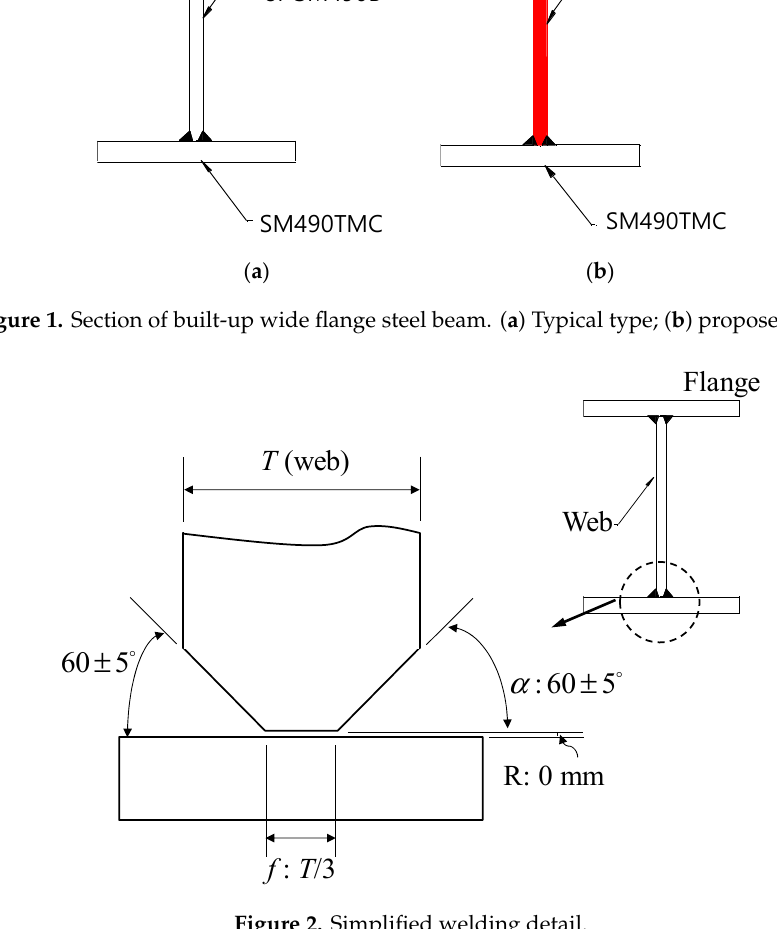
Figure 2. Simplified welding detail. Table 1. Properties of grade 490 steels.